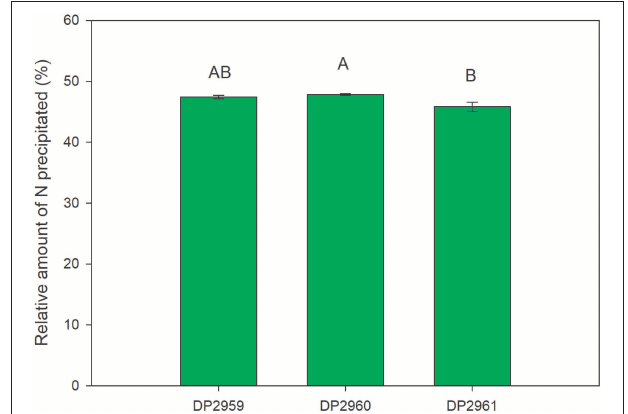
FIGURE 1 | Relative amount of total N precipitated from spinach juice for the three different types of lignosulfonates. Values are means and standard deviation of two replicates. Data were analyzed with ANOVA followed by a Tukey HSD test. Different letters denote significant difference at P =